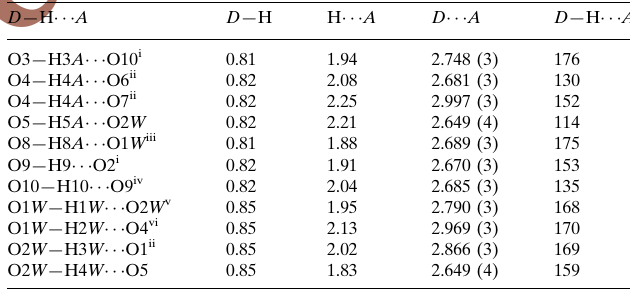
Hydrogen-bond geometry (A˚ , (cid:2)